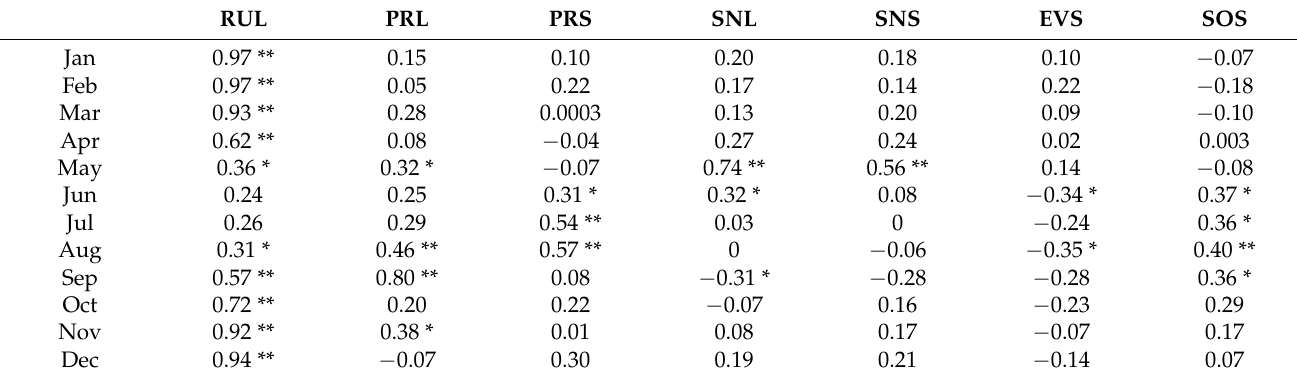
Table 1. Correlation coefficients of runoff and impact factors in different